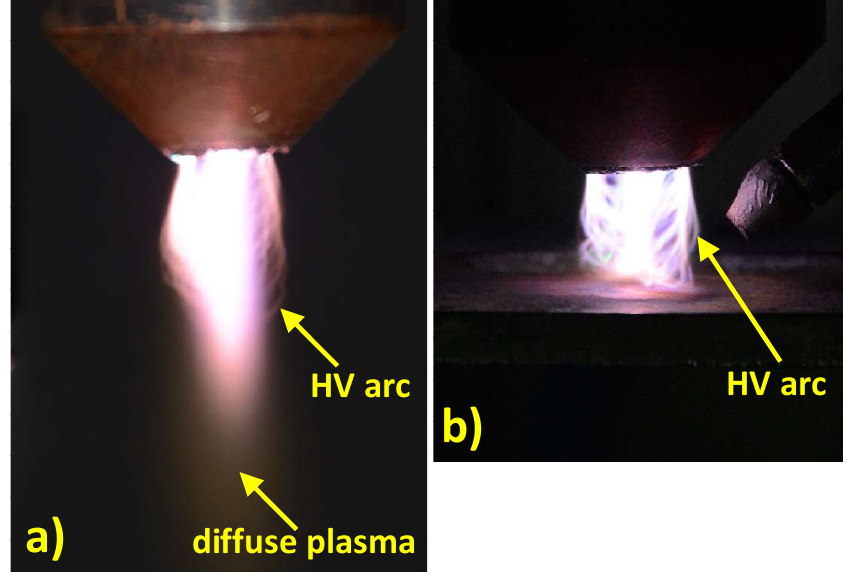
Figure 3. The plasma jet with no arc transfer ( a ) in free space and ( b ) directed on a non-grounded metallic substrate. Conditions: forming gas 95/5, flow 60 SLM, frequency 62 kHz, power 100%.